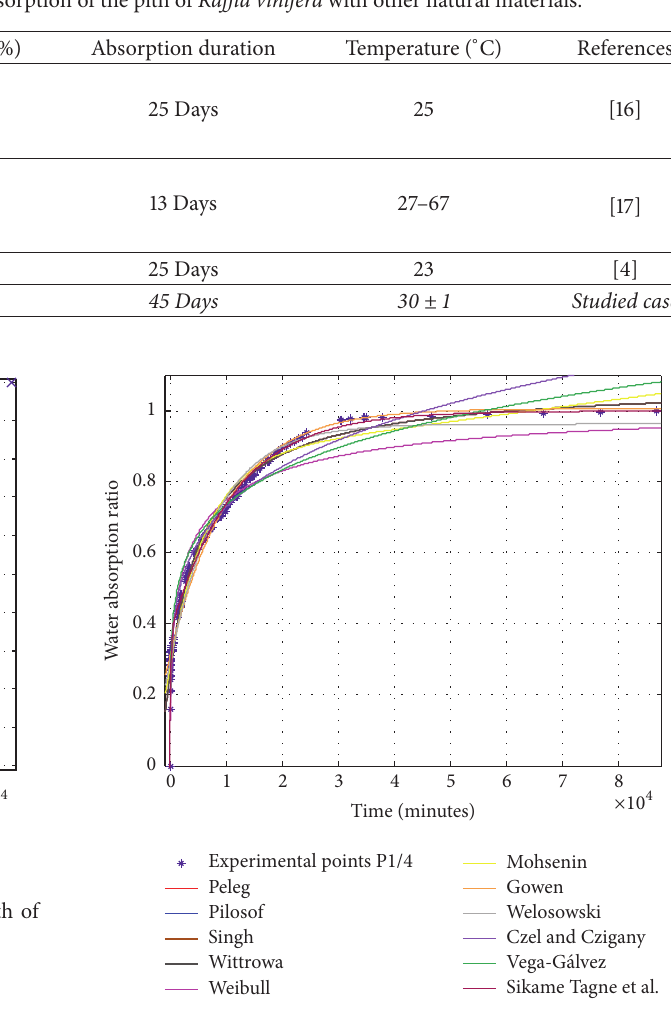
Figure 5: Experimental curve of the pith of Raffia vinifera and curves of